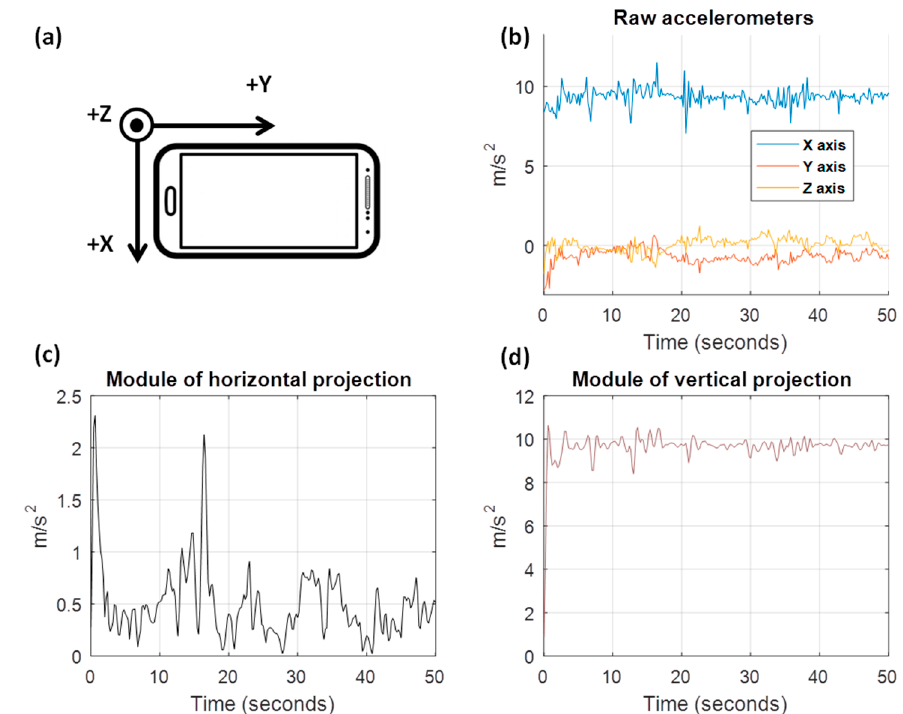
Figure 2. Signals obtained from Android smartphone. ( a ) Position of the mobile while the journey was recorded. ( b ) Raw accelerometers. ( c ) Horizontal projection module. ( d ) Vertical projection module.